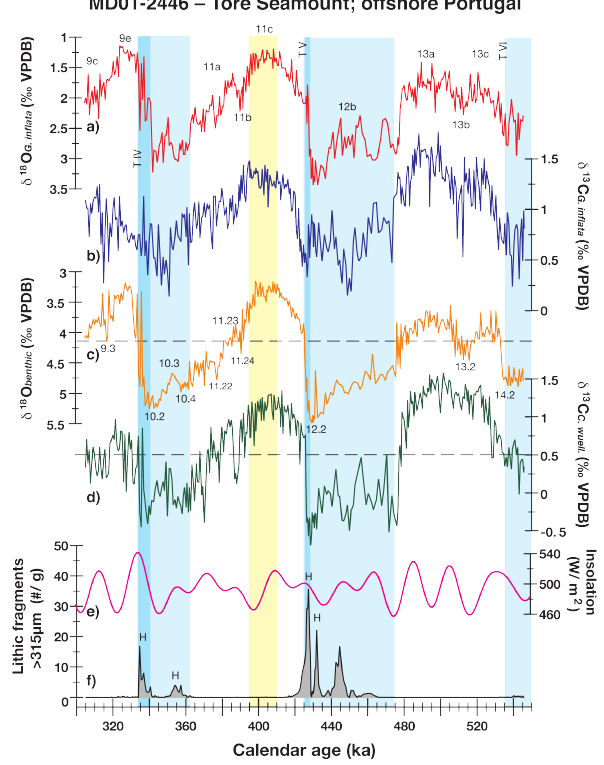
Fig. 4. Records for core MD01-2446, the offshore site off Por- tugal: (a) G. inflata δ 18 O (‰VPDB; red), (b) G. inflata δ 13 C (‰VPDB; blue), (c) benthic δ 18 O (‰VPDB; orange), (d) epiben- thic δ 13 C (‰VPDB; green), (e) 21 June insolation at 65 ◦ N (Laskar et al., 2004; magenta), and (f) lithics concentration (#/g; black). Light blue bars mark glacial MIS 10, 12 and 14; dark blue bars the Heinrich-type events at the Terminations; and the yellow bar the MIS 11 sea level highstand. Substages (e.g. 11c) are indicated on the G. inflata δ 18 O record (a) and isotopic events (e.g. 10.4) on the benthic δ 18 O record (c). Dashed line in c) designates the ice volume threshold of McManus et al. (1999) and in d) the NADW/Antarctic Bottom Water boundary. T IV, V and VI refer to Terminations VI, V and VI. H indicates Heinrich-type ice-rafting